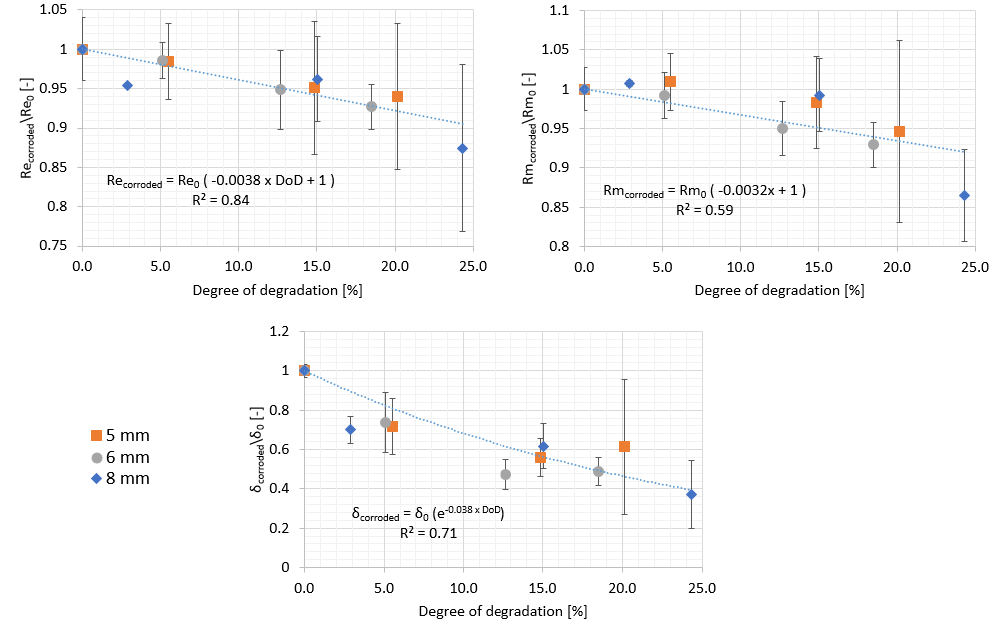
Figure 6. Normalised mechanical properties as a function of degree of degradation [32].